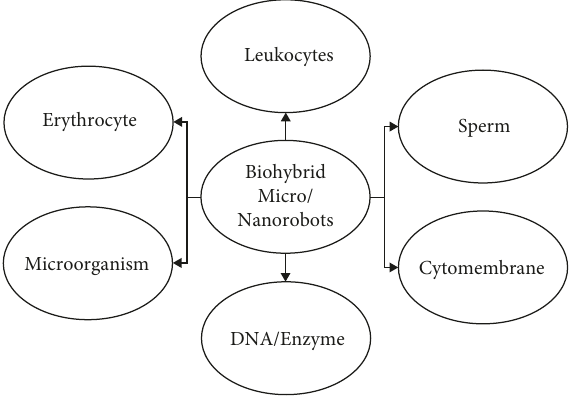
Figure 2: Different kinds of biohybrid